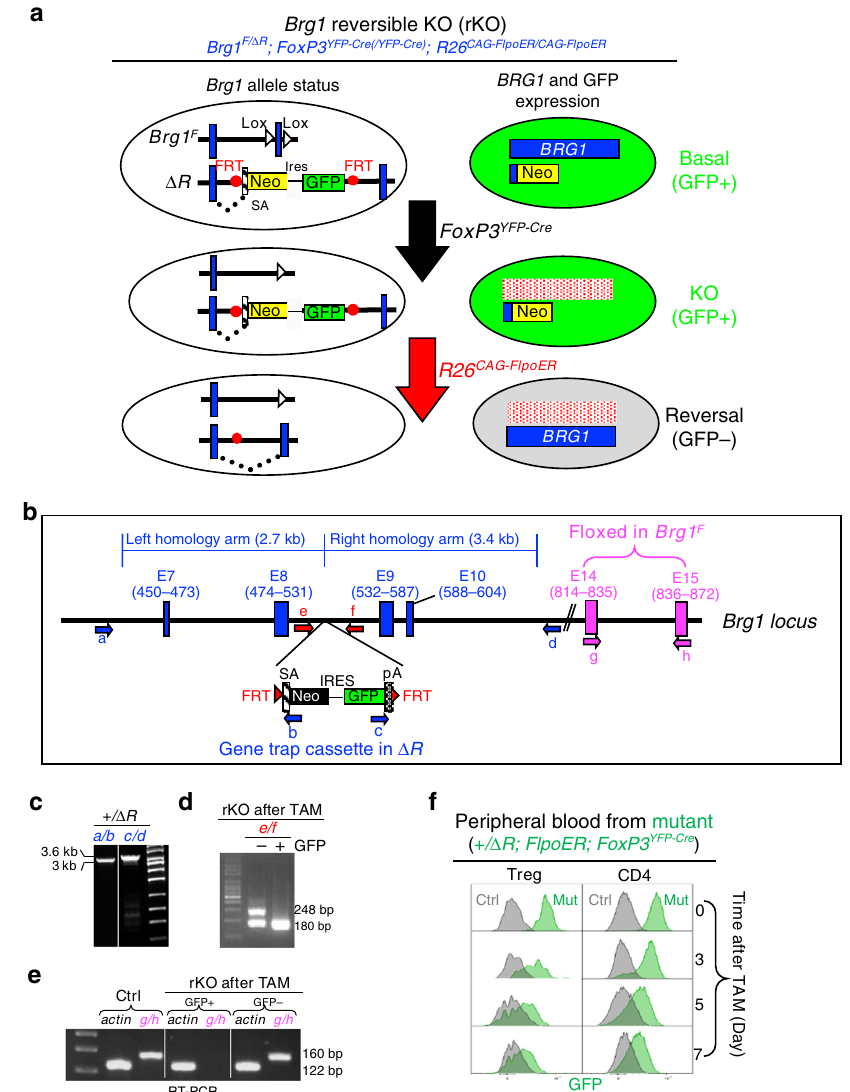
Fig. 1 Creation of Brg1 -reversible KO model using the LOFT method. a Strategy for GFP-labeled, Treg-speci fi c reversible Brg1 knockout. This method requires a conventional Brg1 - fl oxed allele ( Brg1 F ) paired with a multifunctional reversible KO ( Δ R) allele (top left), and sequential action of Cre and Flpo recombinases (middle and bottom). Depicted is the status of the Brg1 alleles (left) and the corresponding BRG1 protein expression patterns (right). Note that Cre was expressed from the endogenous FoxP3 locus located on the X chromosome subject to random inactivation, and so the reversible KO (rKO) mice carried either one or two FoxP3 YFP-Cre alleles depending on the sex. SA splicing acceptor, Neo neomycin-resistance gene, FRT fl ippase-recognition target (red dot). b The Brg1 alleles. The gene-trap cassette in Δ R is inserted after E8 in the Brg1 locus, and the fl oxed exons in Brg1 F highlighted in pink. Also depicted are the homology arms used to make the targeting construct for generating Δ R , and the PCR primers for genotyping. c – e Characterization of mouse samples. Shown are the representative results from two biological replicates. The tail from a Brg1 + / Δ R mouse was subjected to PCR analysis using primer pairs a/b and c/d (depicted in b ) to verify successful targeting ( c ); GFP + and GFP − Tregs isolated from TAM-treated rKO mice were analyzed by PCR and RT-PCR to detect the excision of the gene-trap cassette ( d ) and restoration of Brg1 expression ( e ), respectively. The control mouse in e has the same genotype as rKO, except that it carried Brg1 + instead of Brg1 Δ R . f Kinetics of GFP loss following TAM administration. TAM (full dose) was given via oral gavage, and GFP expression in Tregs and conventional CD4 cells in tail blood monitored by FACS. The control mouse did not carry Brg1 Δ R the E/M and Naive subset constituted 76% and 16% of the total CD4 population, respectively (as opposed to 14% and 79% in the WT mice, Fig. 2d, top). TAM treatment (full dose) led to pro- (Fig. 2a). Gross signs of in fl ammation disappeared within nounced and progressive depletion of the E/M CD4 cells and 2 months after TAM administration (Fig. 2b), and by 120 days, simultaneous accumulation of the naive CD4 cells, which became the runted mice had fully caught up in weight and size, revealing apparent within 2 weeks after the treatment (Fig. 2d, e). The striking resilience of the mice (Fig. 2c). To directly examine the reciprocal changes in the abundance of the E/M vs. naive CD4 kinetics of in fl ammation resolution, we monitored the proportion cells were not due to the conversion of the E/M to naive CD4 cells of effector/memory-like (E/M, CD44 hi CD62L lo ) and naive-like (Naive, CD44 lo CD62L hi ) CD4 cells within the CD4 cell popu- (Supplementary Fig. 1), and so might instead re fl ect the changes lation in peripheral blood (Fig. 2d). In a 3-week-old rKO1 mouse, in their apoptosis/proliferation rates.